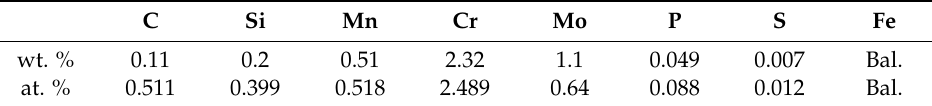
Table 2. Chemical Composition of 2.25Cr-1Mo